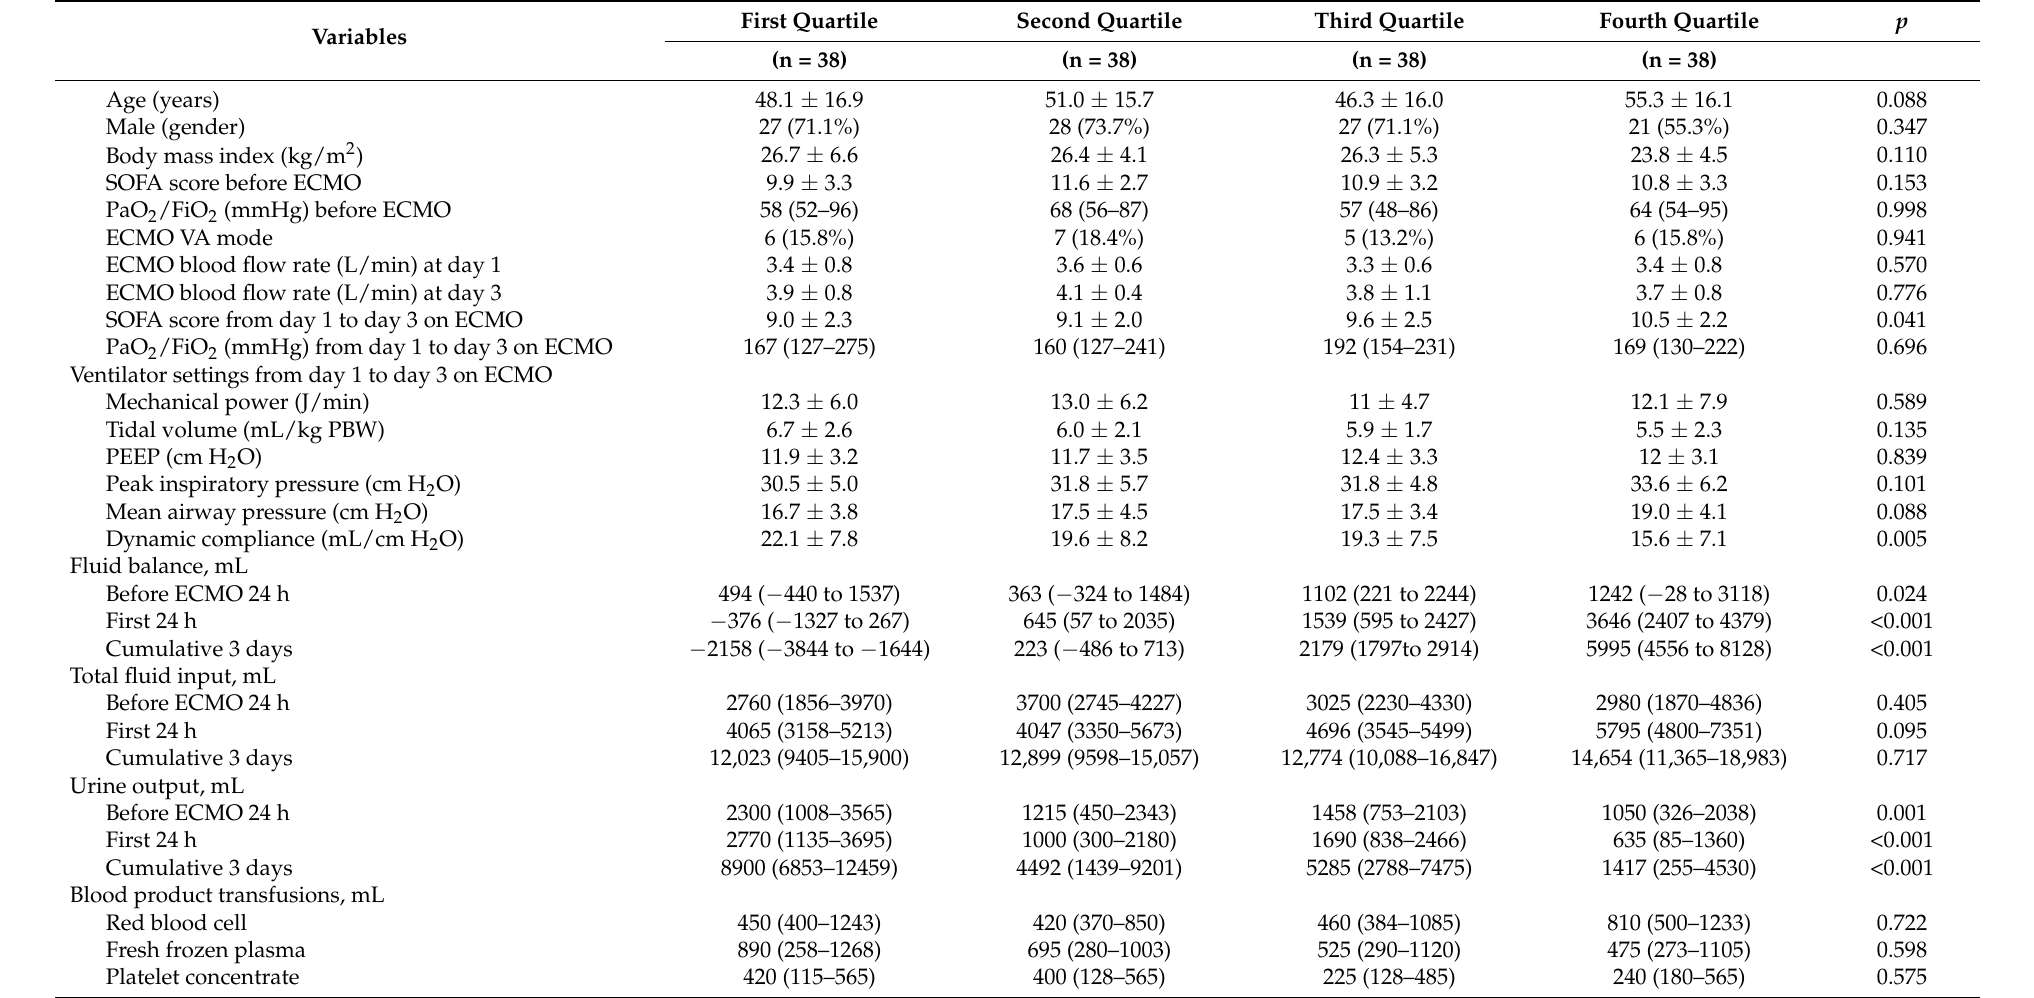
Table 2. Background characteristics and clinical variables as a function of quartiles of cumulative fluid balance at 3 days after